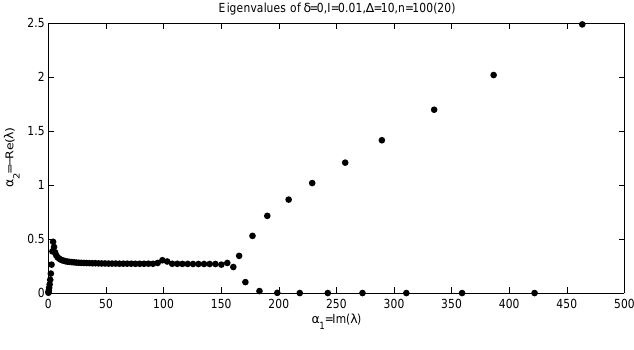
Figure 1. Eigenvalues α ( k ) of δ = 0 , I = 0 . 01 , ∆ = 10 , n = 100(20)